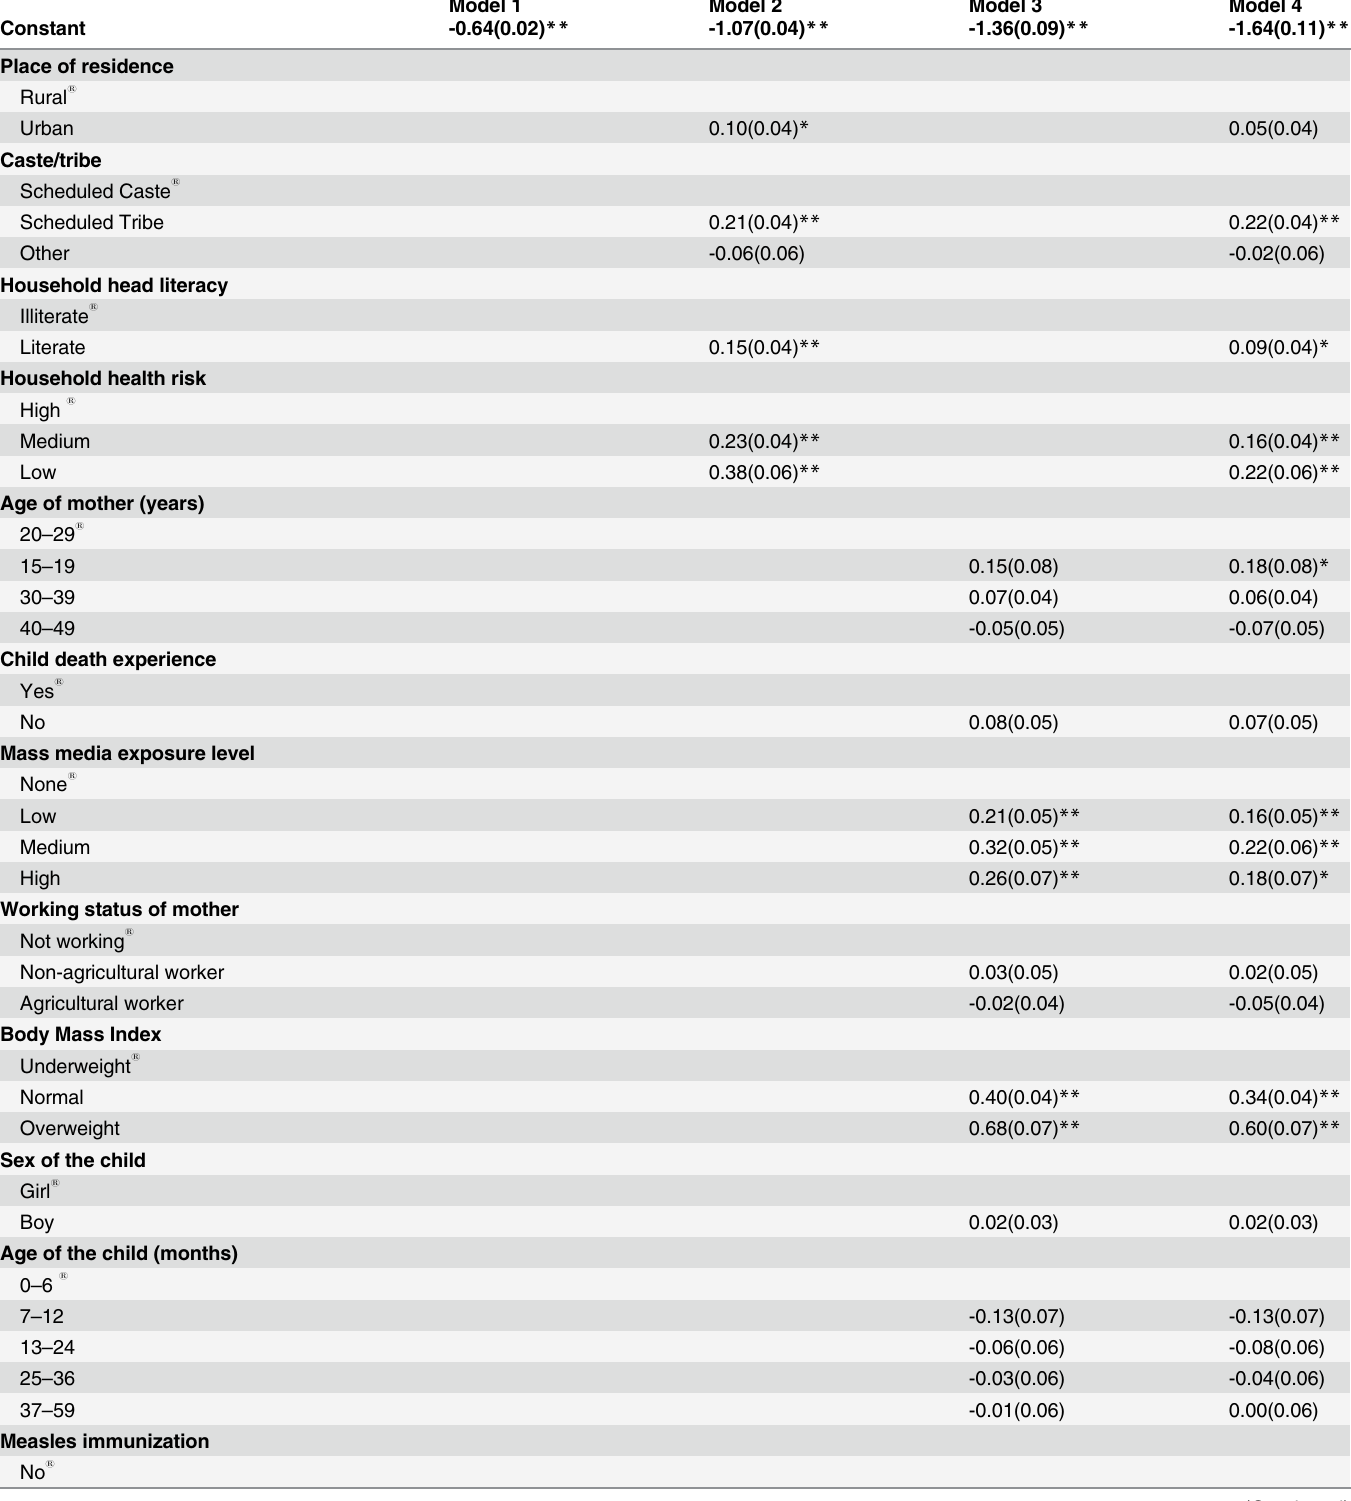
Table 3. Estimated effects and significance levels of selected background characteristics on z-score of